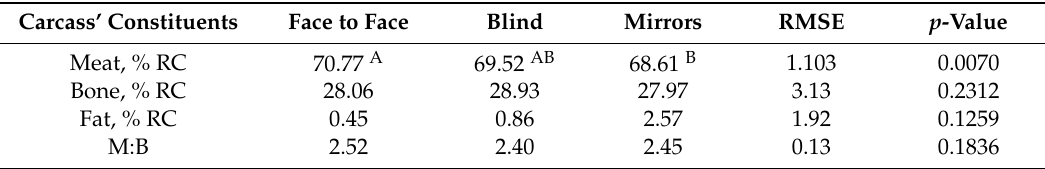
Table 5. E ff ect of the housing systems on the percentage of meat, bone, fat and on the meat to bone ratio (M:B) calculated on the whole carcass. Carcass’ Constituents